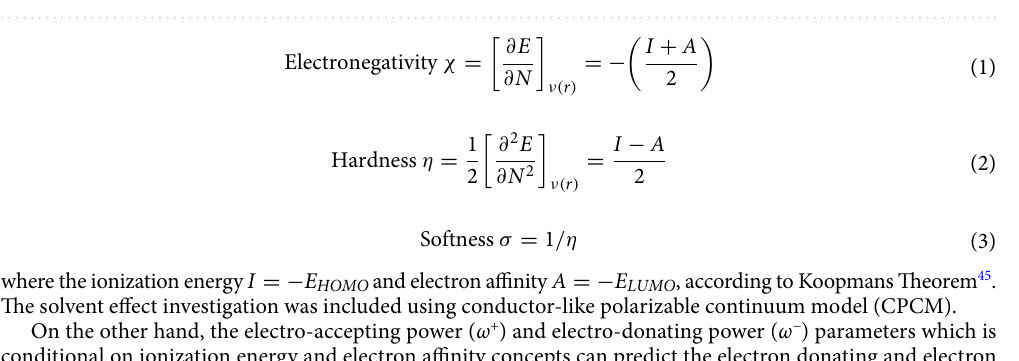
Figure 1. ( A ) CVs recorded for 5.0 μM CC at polysorbate/CPE with different immobilization volume of polysorbate 80 solution. ( B ) Graph of peak current of CC versus volume of polysorbate